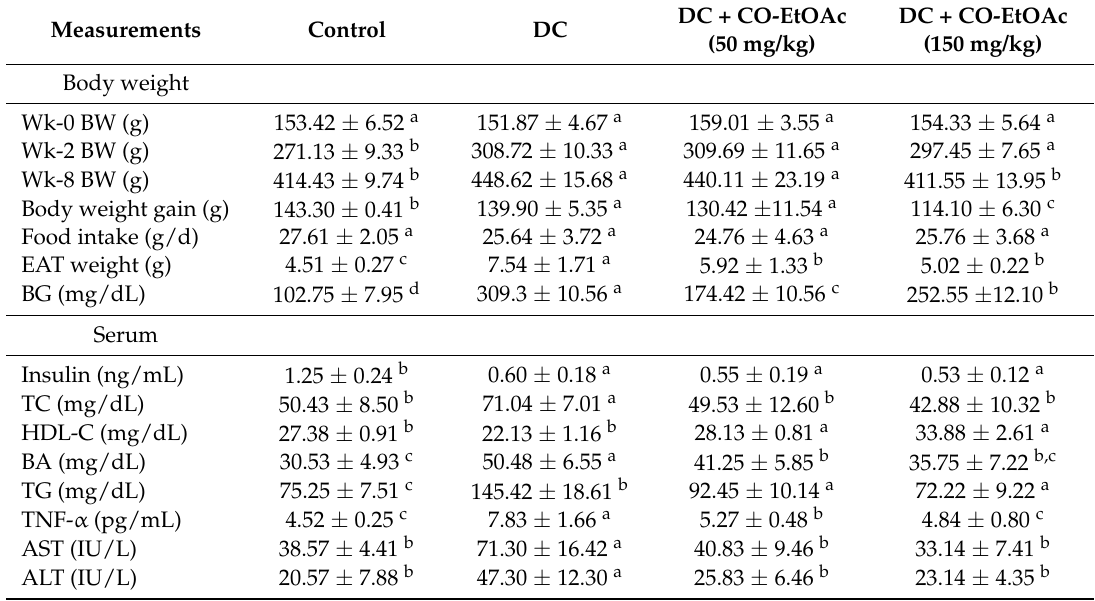
Table 2. Body weight, food intake and biochemical characteristics in diabetic rats.